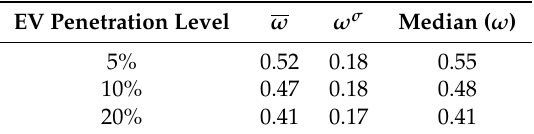
Table 8. Battery cycle usage results for various EV penetration